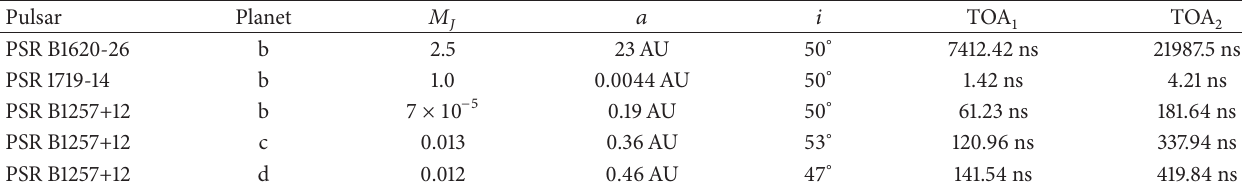
Table 2: TOA produced by hypothetical exomoons orbiting the known pulsar